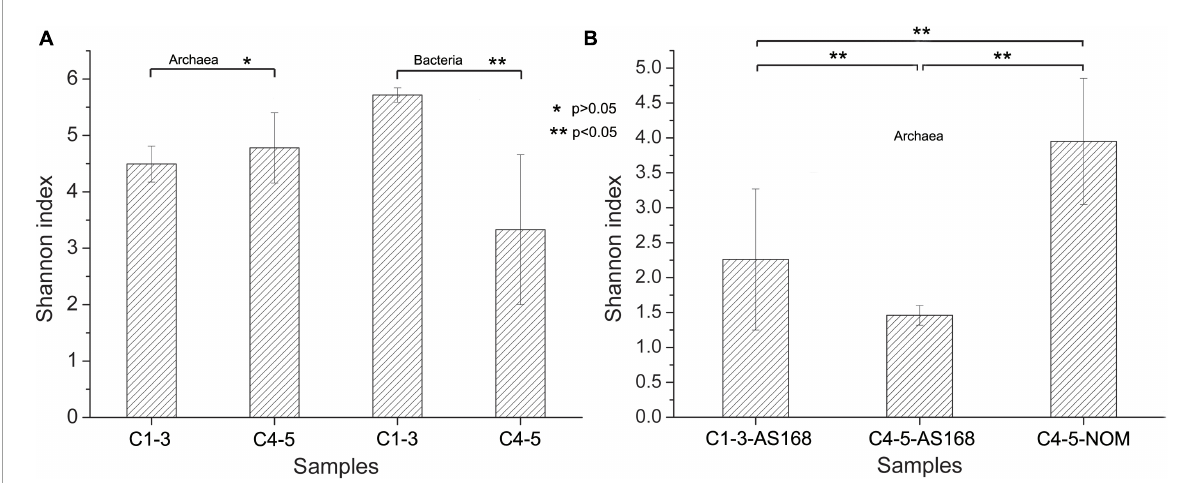
FIGURE3 Species diversity of different brine samples revealed by Shannon index. The species diversity was shown using 16S rRNA-based high-throughput sequencing technology under culture-independent (A) and culture-dependent approaches (B) . * p > 0.05, ** p < 0.05. Archaea, archaeal 16S rRNA gene primers were used; Bacteria, bacterial 16S rRNA gene primers were used; AS-168 medium, colonies grown on the AS-168 medium were collected for the archaeal 16S rRNA-based high-throughput sequencing; NOM medium, colonies grown on the NOM medium were collected for the archaeal 16S rRNA-based high-throughput sequencing; C1-3, three samples collected in July 2021; C4-5, two samples collected in August